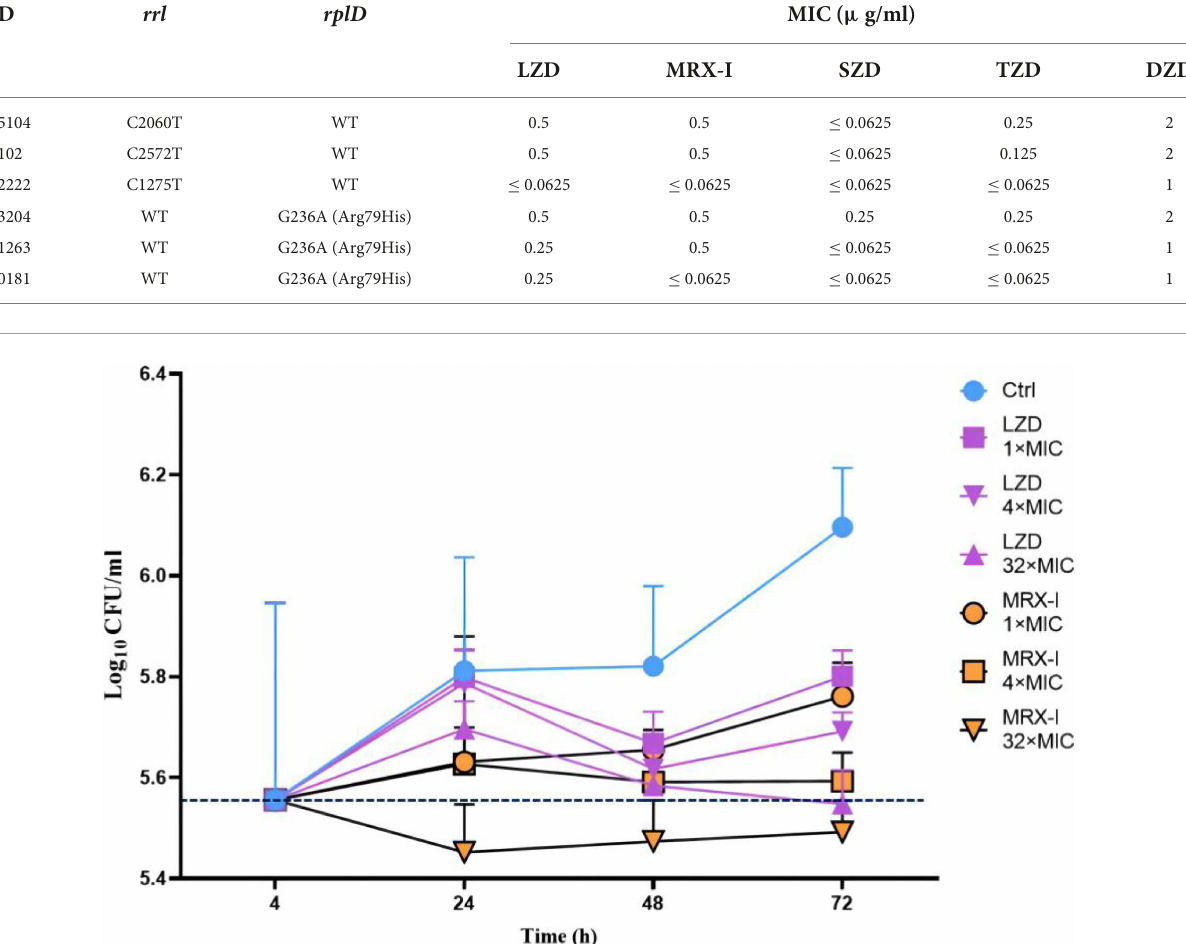
TABLE 4 Mutations located in rrl and rplD in six Mtb clinical strains and MICs of five oxazolidinones.